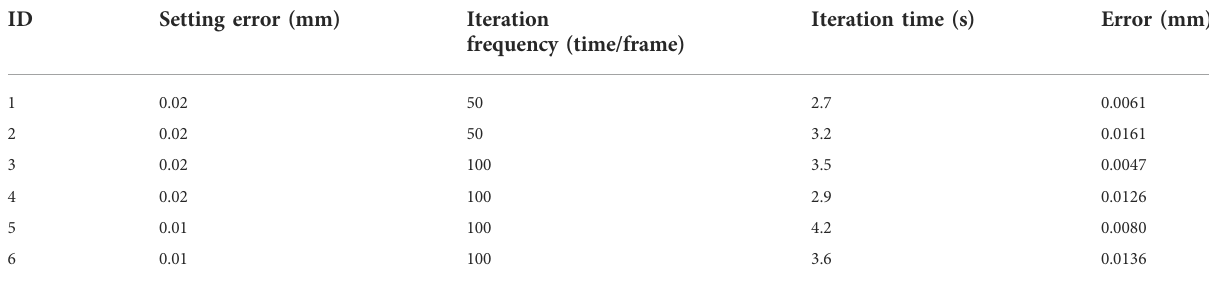
TABLE 1 Inverse kinematics drive system